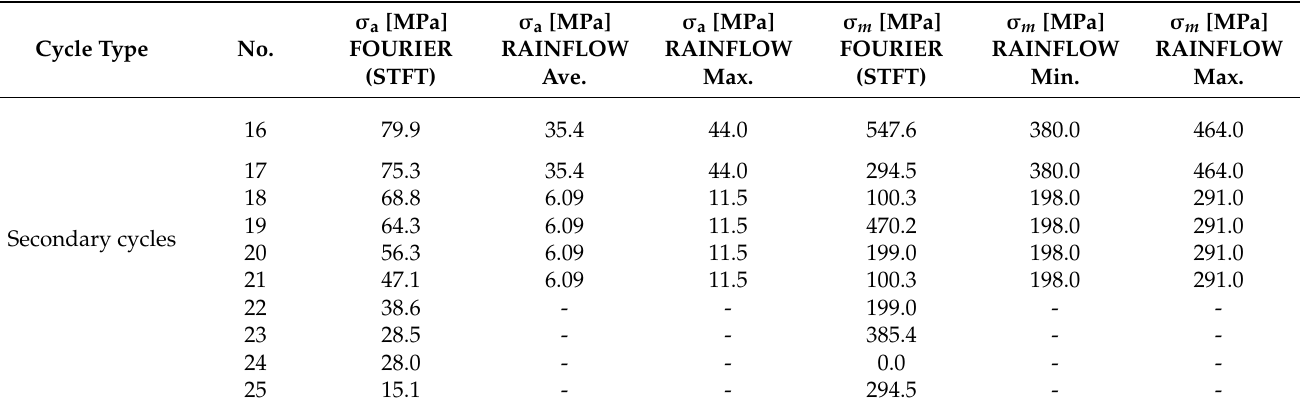
Table 3. Comparison of identified mean values and amplitudes of cycles based on rainflow and Fourier methods for stress variation defined by (9).